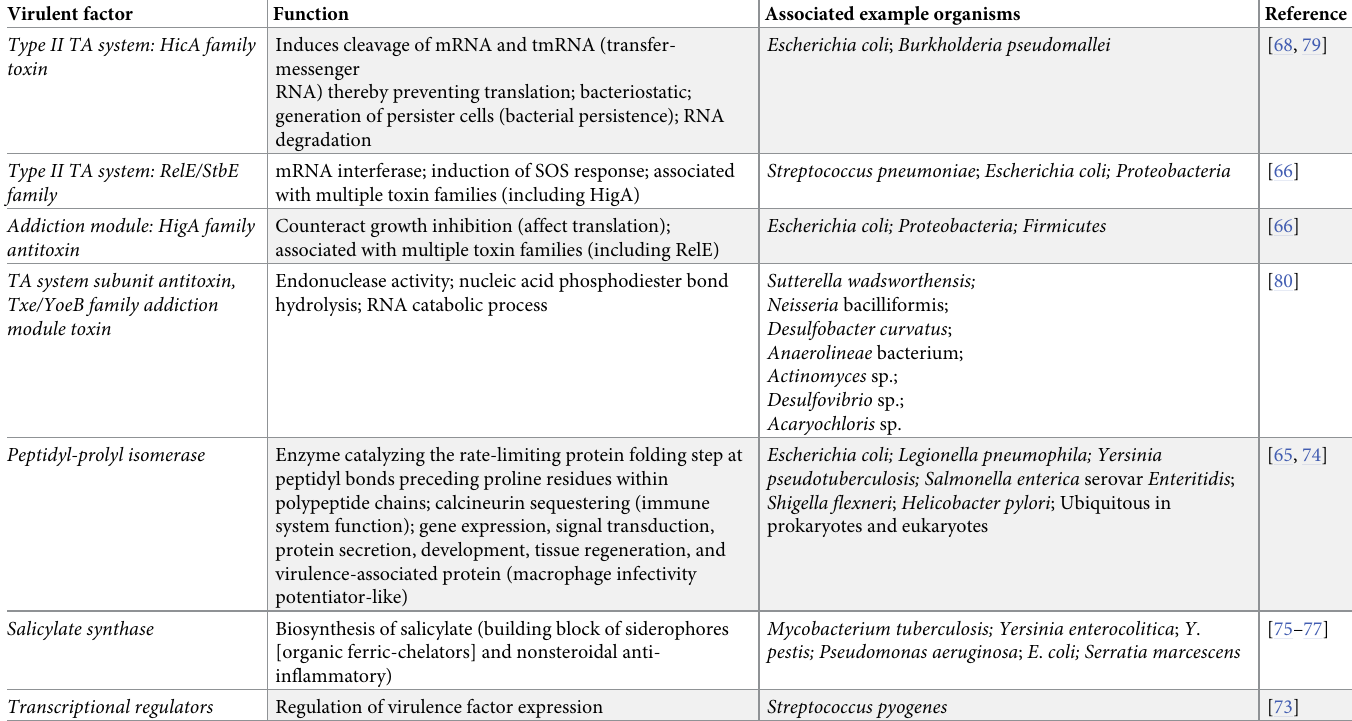
Table 4. Virulence factors found in 3 or more C . bovis isolates, their function, and associated microorganisms where these factors have been